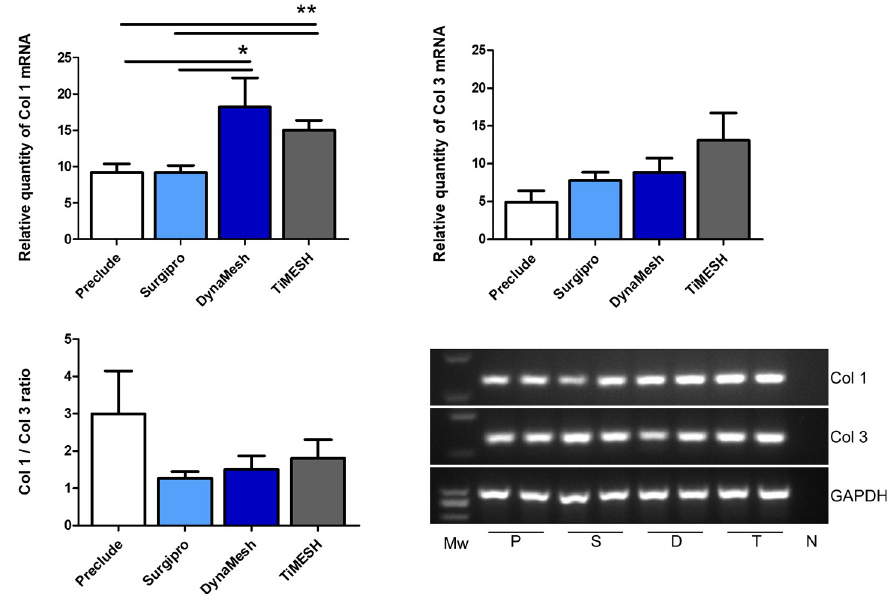
Fig 8. Collagen 1 and 3 mRNA expression levels determined by RT-PCR in the implant areas. Relative mRNA levels of collagen 1, collagen 3 and the Col1/Col 3 ratio in implant samples from the different experimental groups. Gene expression was normalized to the expression recorded for the reference gene GAPDH. Agarose gel electrophoresis of RT-PCR products is shown. Each pair of lanes is representative of each experimental group: P, Preclude; S, Surgipro; D, DynaMesh; T, TiMESH. Mw: Molecular weight markers. N: Negative. Collagen 1 mRNA expression was statistically greater in the hybrid meshes DynaMesh ( � , p < 0.05) and TiMESH ( �� , p < 0.01) compared to Surgipro and Preclude. No differences were found in collagen 3 mRNA expression levels or the Col1/Col3 ratio.